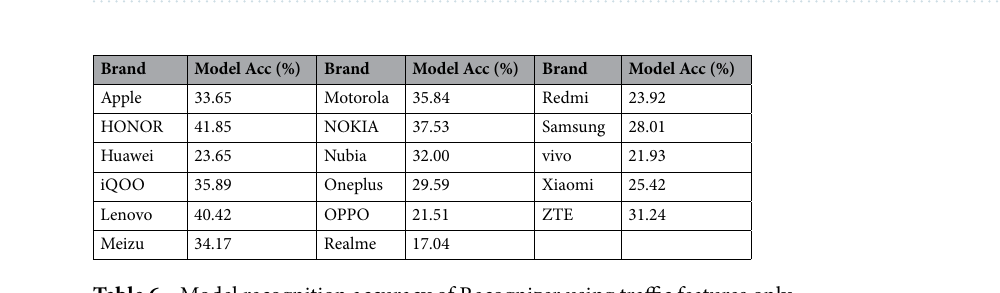
Table 6. Model recognition accuracy of Recognizer using traffic features